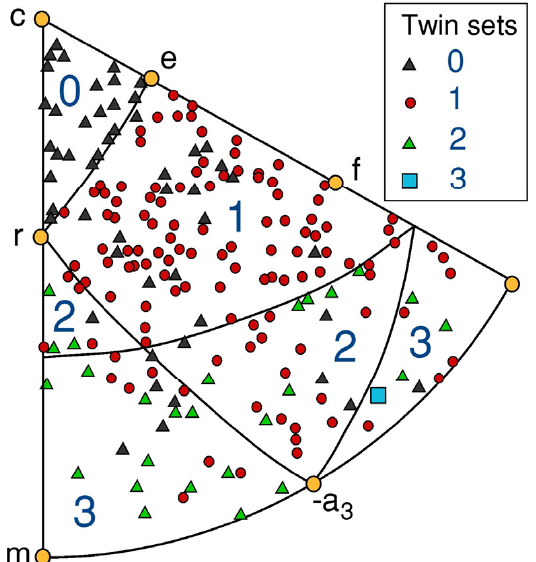
Figure 9. Inverse pole figure of σ 1 directions plotted in the crystallographic reference frame. The figure shows those areas for which a positive Schmid factor applies to 0, 1, 2 or 3 sets of potential twin lamellae, assuming homogeneous stress. σ 1 directions are coded according to the number of twin systems active in the grain.